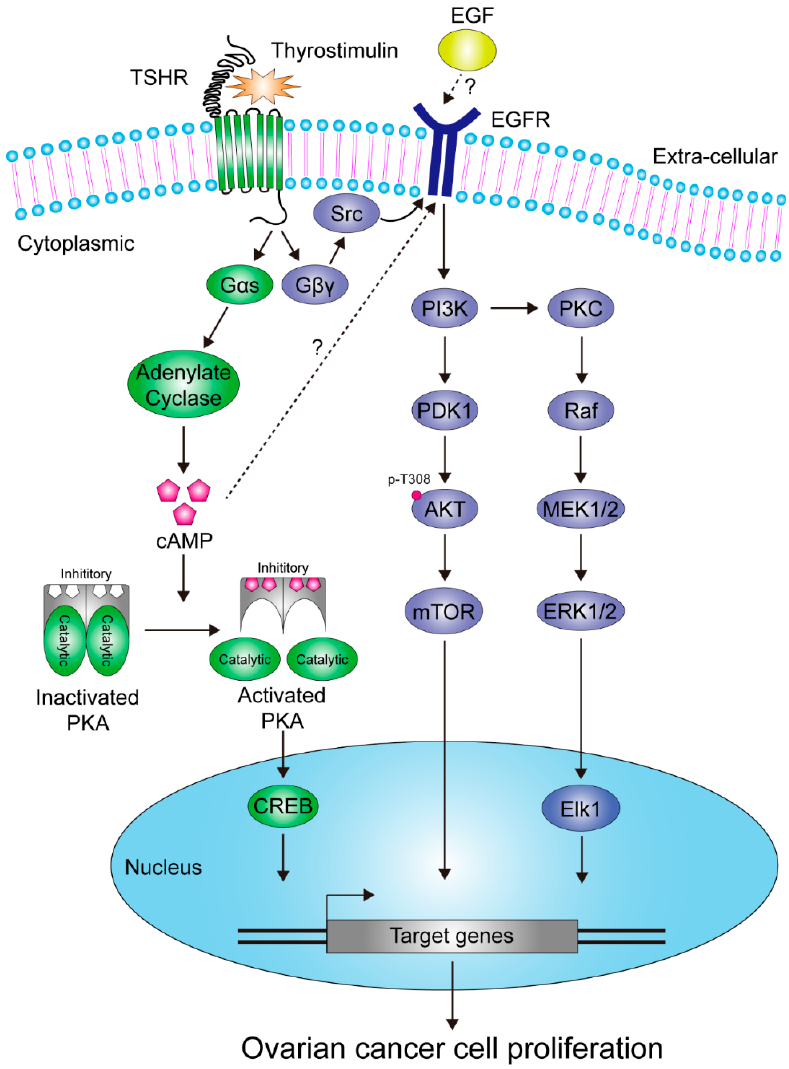
Figure 3. Schematic representation of the identified effectors and pathways downstream of TSHR in response to thyrostimulin stimulation in ovarian cancer cells.